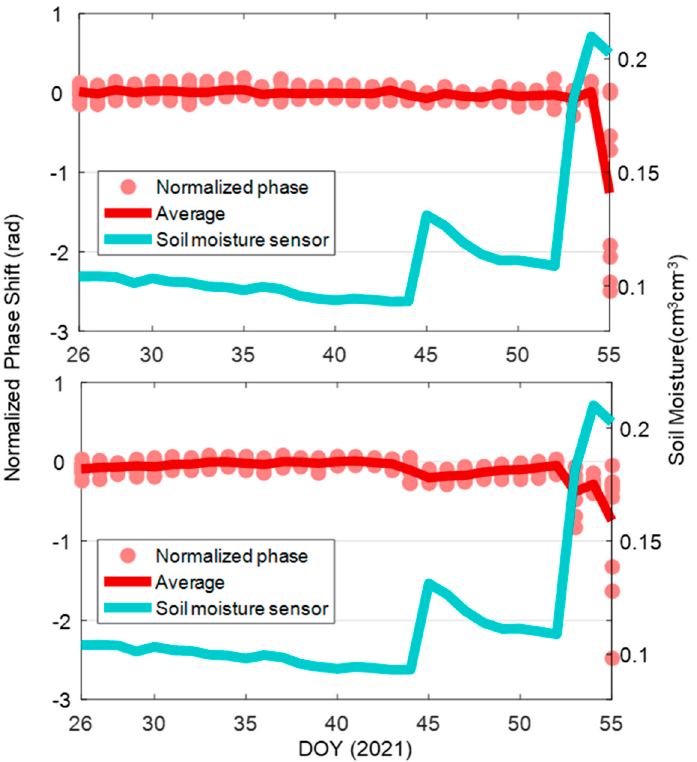
Figure 8. Normalized phase shift sequences of all BDS IGSO satellite tracks and the phase shift average results: ( upper ) B1I results; ( lower ) B2I results.